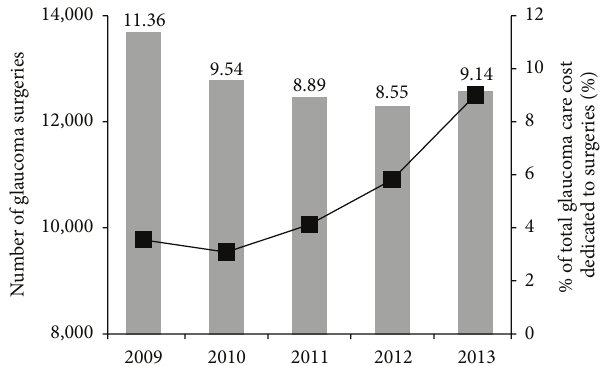
Figure 2: Trends in glaucoma surgery costs and number of proce- dures in Korea. The number of glaucoma surgeries performed (black squares) increased annually, but the proportion of total glaucoma care costs associated with glaucoma surgery (gray bars) decreased annually. Both trends were statistically